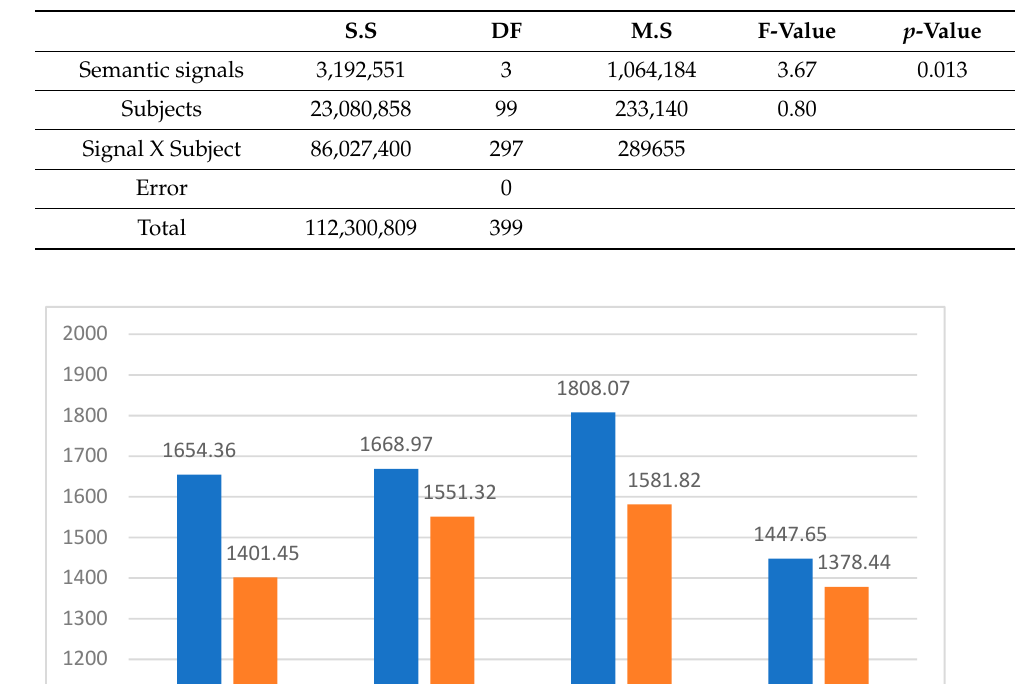
Table 11. ANOVA results for emotional semantic signal group.